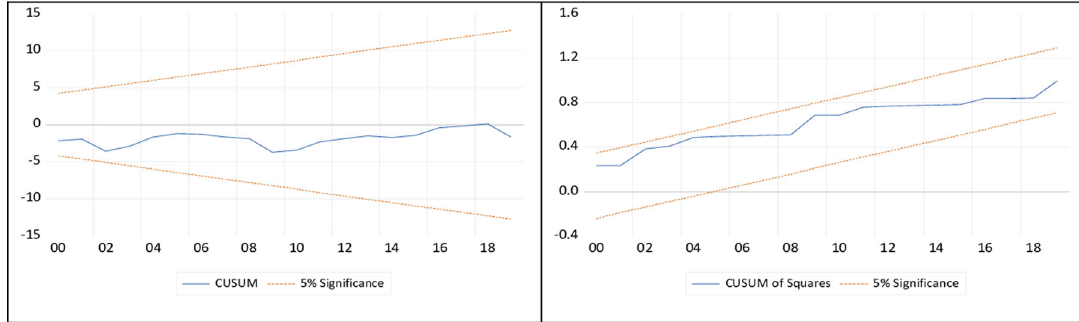
Fig. 4 CUSUM and CUSUM of sq. graphs.